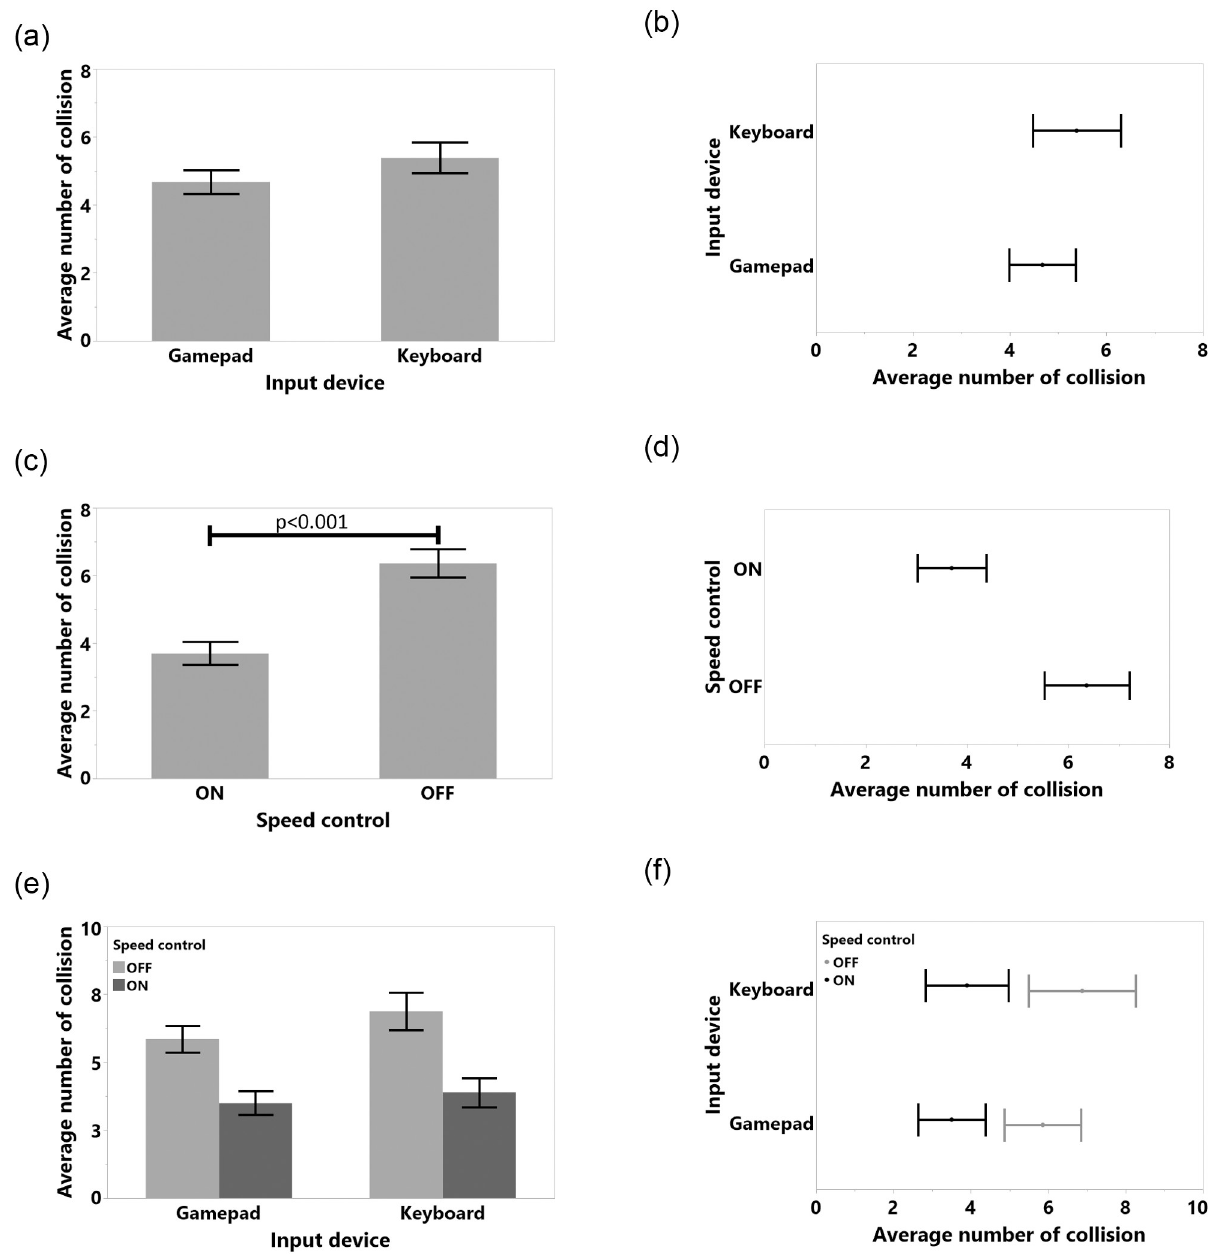
Fig 7. Means and standard error of means for average number of collisions for (a) input device, (c) speed control, (e) input device and speed control interaction. Means and 95% confidence intervals for number of collisions for (b) input device, (d) speed control, (f) input device and speed control